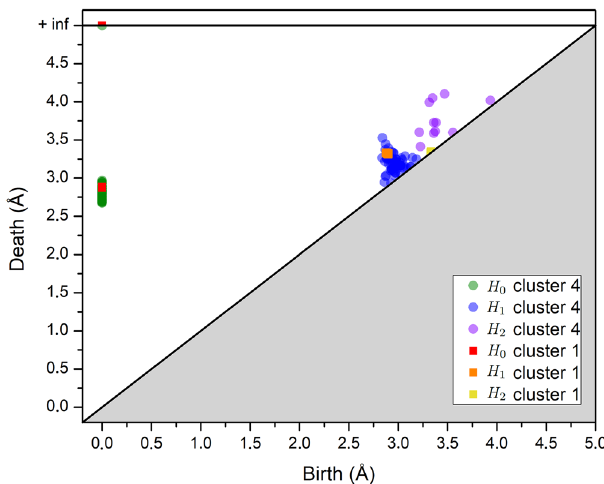
Figure 6. Persistence diagrams of homological dimensions H 0 , H 1 and H 2 for the mean structures of C 1 and C 4 which represent respectively the bcc ordering and the preponderant liquid